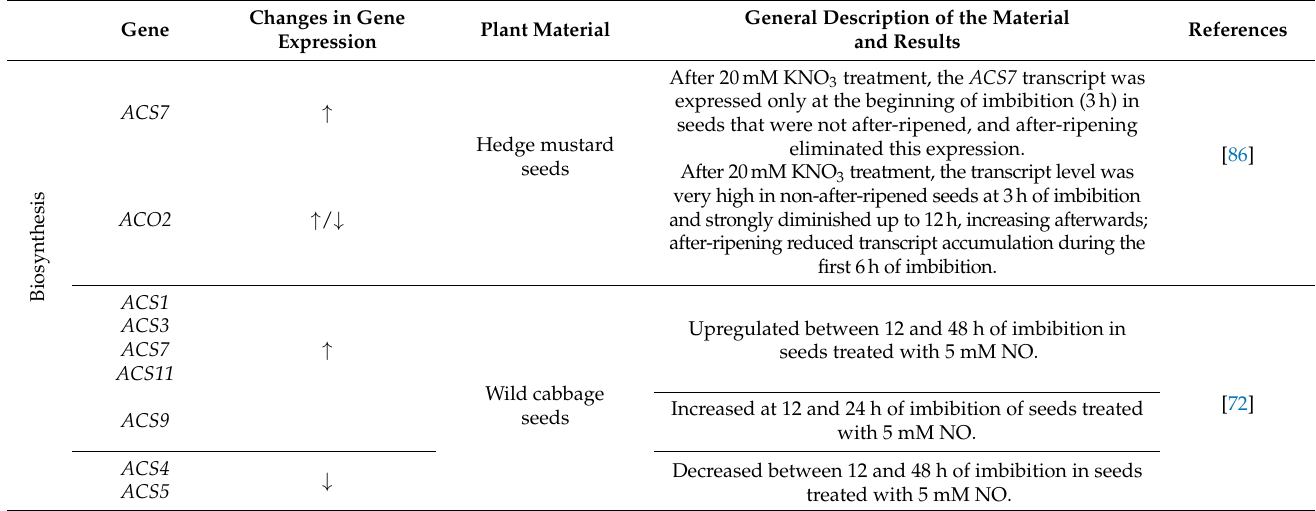
Table 4. NO-dependent changes in the expression of genes related to ET metabolism and signalling in